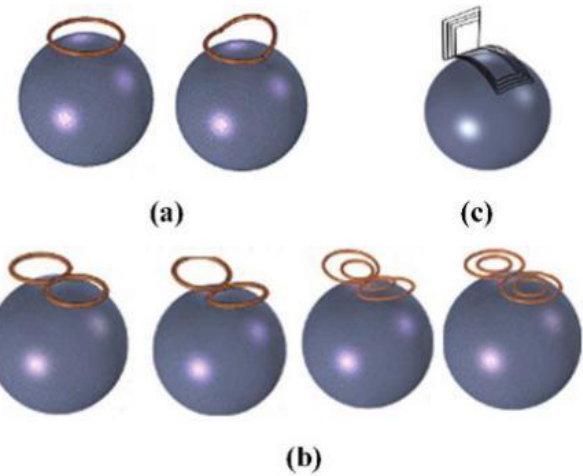
Figure 8. The structure of the TMS coil. ( a ) Circular coil. ( b ) Figure-of-eight coil. ( c ) H-shaped coil. Figure-of-eight coils are widely applied in commercial applications. Two coils with opposite currents cause the peak of the induced electric field to appear at the tangent position of the coil [87,88]. Figure 8b shows the figure-of-eight coil. Compared with the circular coil, the focus of the figure-of-eight coil is greatly improved. However, it can only